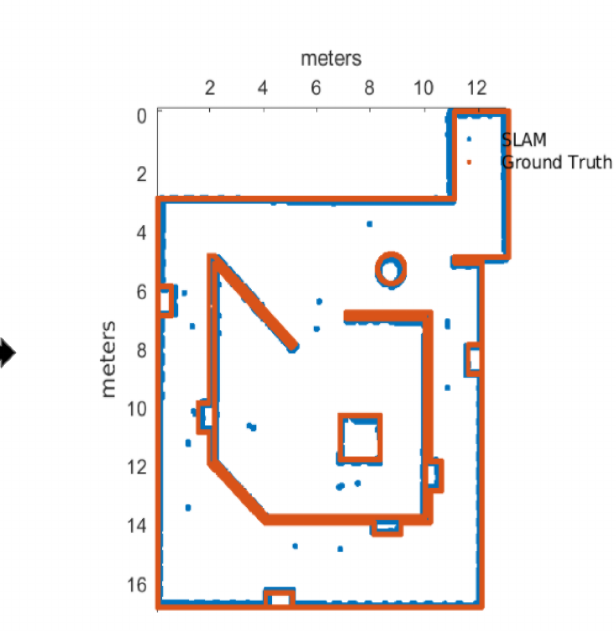
Figure 7. Map before and after the calibration of Cartographer.